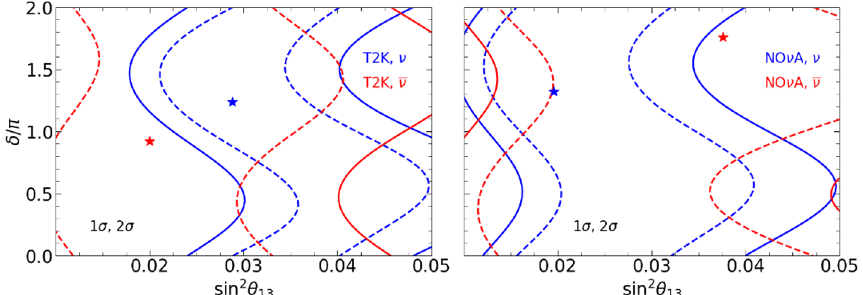
Figure 1 . 1 (cid:27) (dashed) and 2 (cid:27) (solid) allowed regions in the sin 2 (cid:18) 23 {(cid:1) m 2 plane for antineutrinos) for T2K (left) and NO (cid:23) A (right) neutrino (blue) and antineutrino (red) data. The stars correspond to the best (cid:12)t values obtained in each analysis.